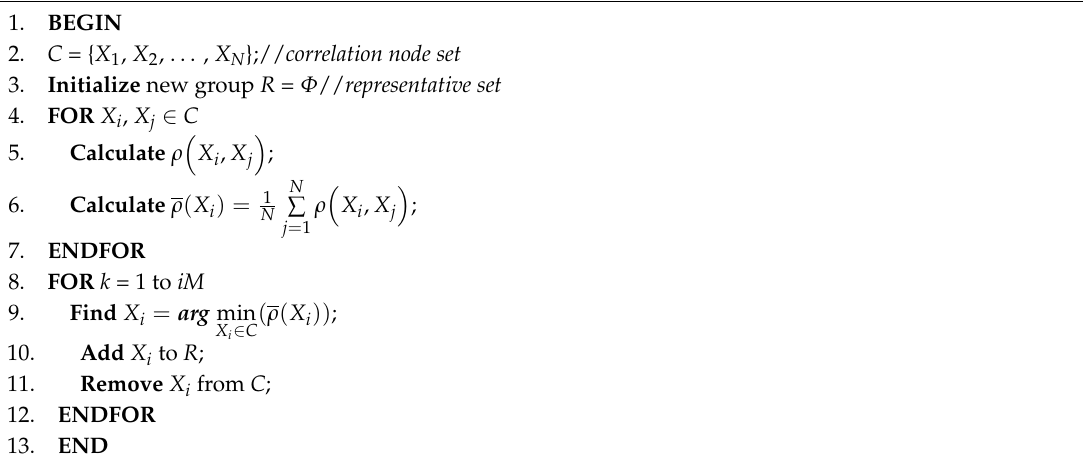
Algorithm 2: Maximizing the Obtained Information-Based Representative Node Selection